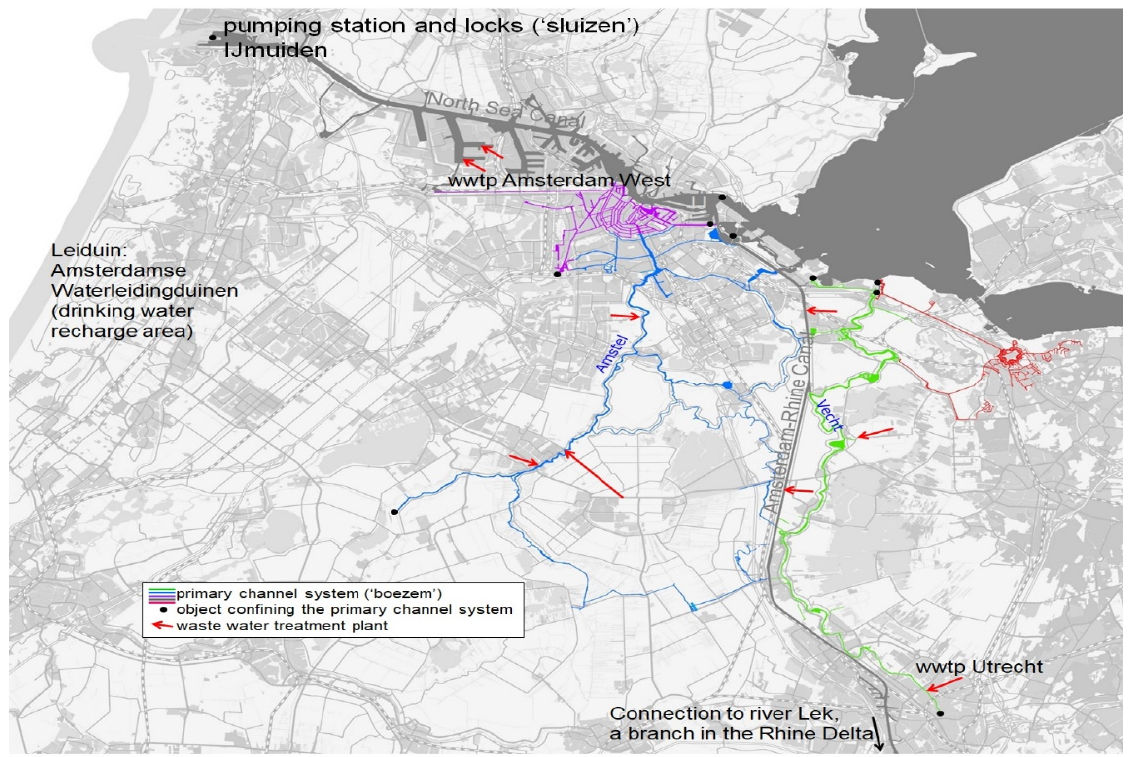
Figure 4. City Blueprint Approach [14–16].